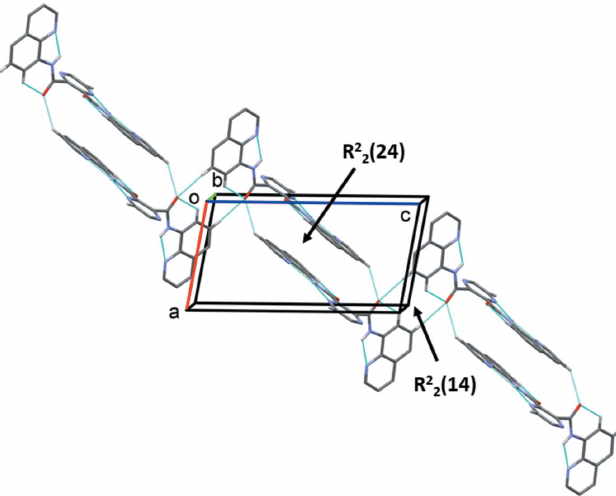
Figure 4 A partial view along the b axis of the crystal packing of ligand H 2 L1 . Hydrogen bonds are shown as dashed lines (see Table 1). For clarity, in this and subsequent crystal packing figures, only the H atoms involved in these interactions have been included. 3.3162 (5) A˚ , with an offset of 1.048 A˚ [symmetry code: (i) (cid:4) x , (cid:4) y + 2, (cid:4) z + 1]. The second offset (cid:2) – (cid:2) interaction involves inversion-related N6/C16–C24 (centroid Cg 3) quinoline ring systems with Cg 3 (cid:3) (cid:3) (cid:3) Cg 3 ii = 3.6526 (8) A˚ , (cid:5) = 0.00 (4) (cid:2) , (cid:6) = 24.1 (cid:2) , (cid:7) = 24.1 (cid:2) , interplanar distance = 3.3333 (4) A˚ , with an offset of 1.494 A˚ [symmetry code: (ii) (cid:4) x (cid:4) 1, (cid:4) y + 1, (cid:4) z ].